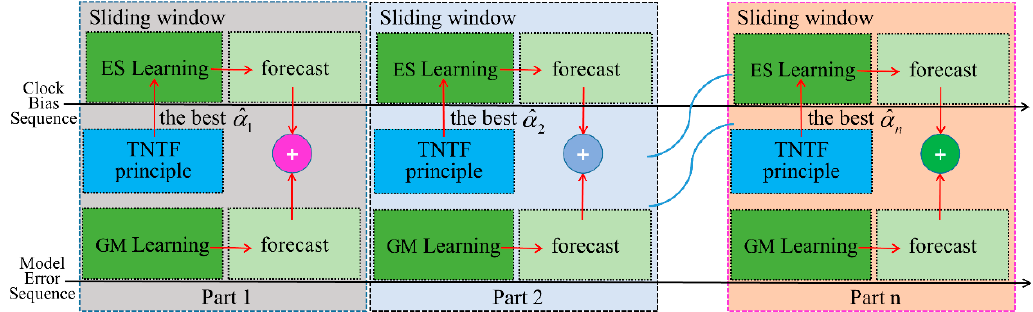
Figure 5. Flow chart of ES + GM clock bias prediction using a sliding window. GM, gray model.